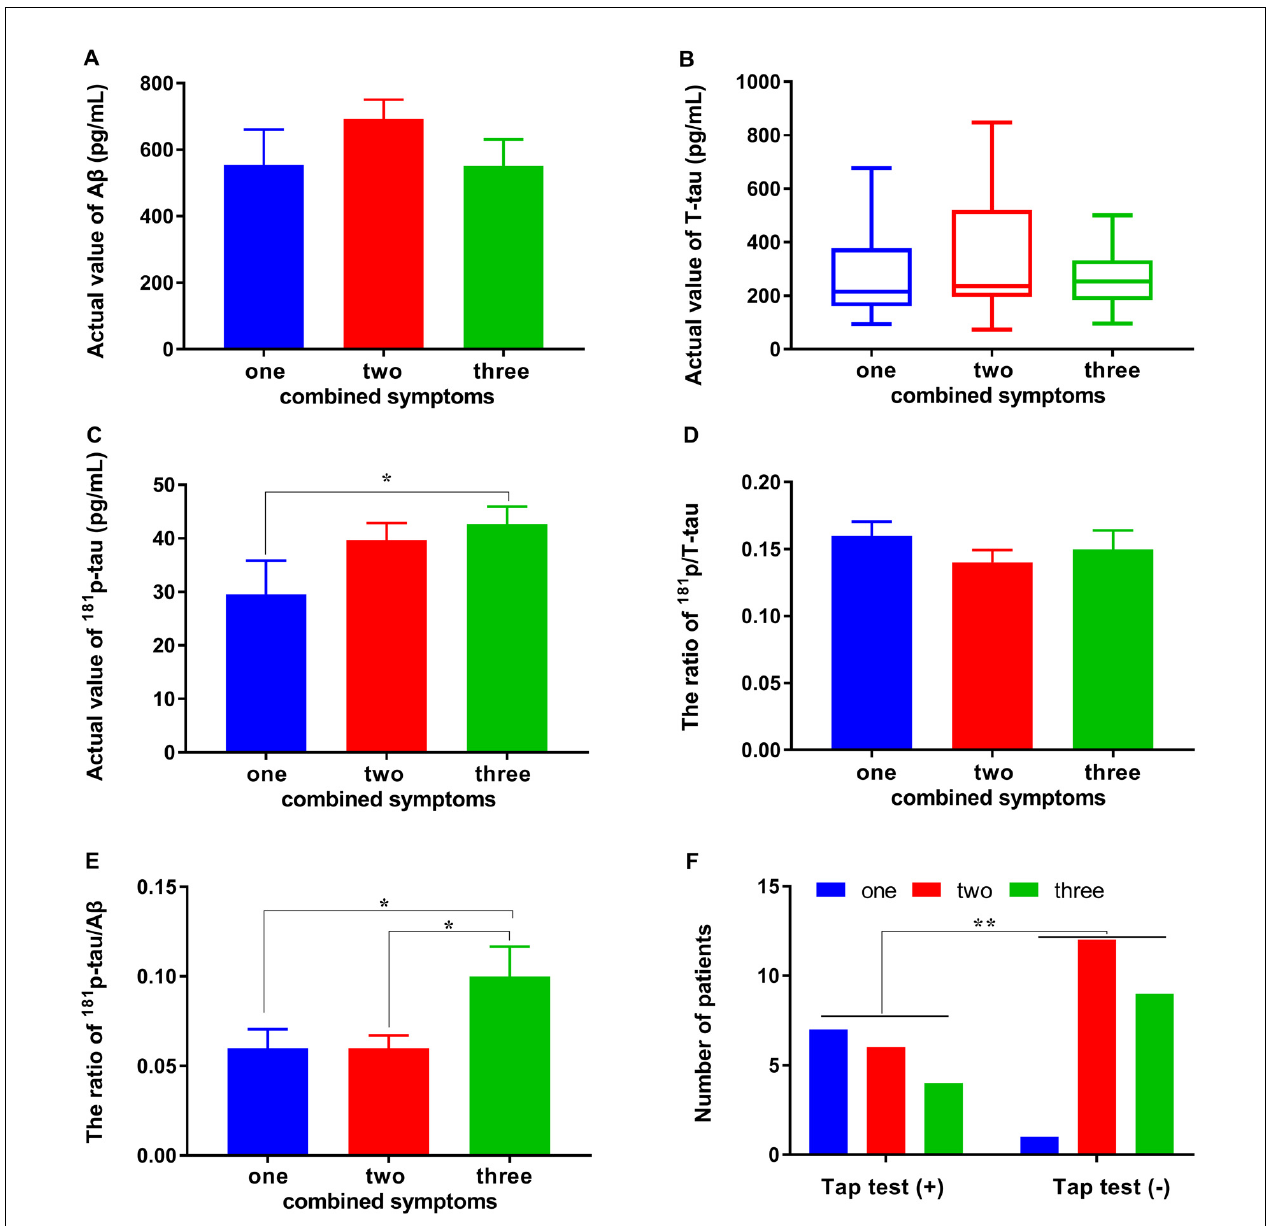
FIGURE 3 | Differences in CSF biomarkers and tap test responsiveness between subgroups with different numbers of combined symptoms. (A–E) Differences in the levels of A β 1–42, T -tau, 181 p/ T -tau, and 181 p -tau/A β 1–42 between the subgroups with different numbers of combined symptoms. (F) The relationship of the tap test responsiveness with number of combined symptoms (* p < 0.05 and ** p < 0.01 compared with the corresponding group. The data in (B) are presented as the medians with interquartile